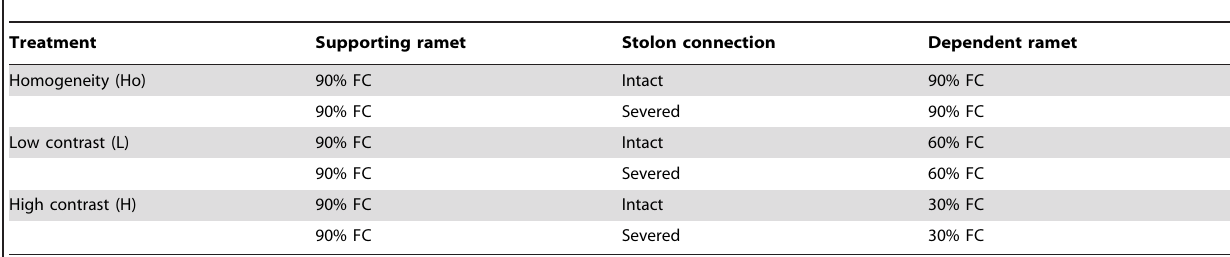
Table 1. Experimental